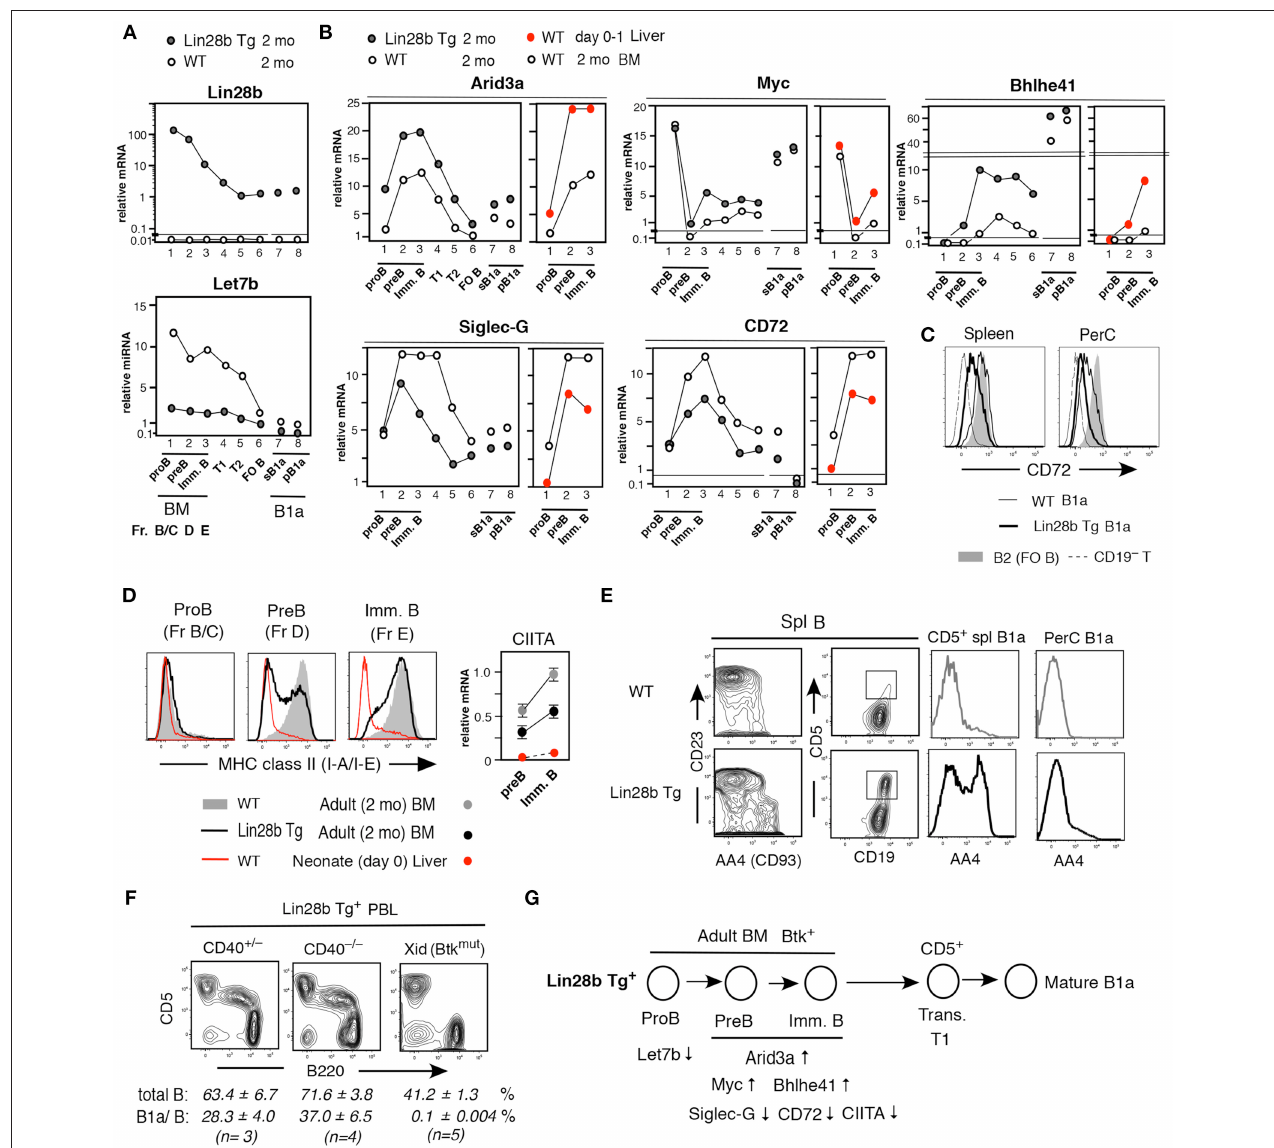
FIGURE 2 | Pre-B and immature B cells in adult Lin28b Tg BM resembles WT fetal/neonatal liver and generate B1a cells. (A,B) qRT-PCR. Adult (2 mo) Lin28b Tg mouse B lineage in BM, B cells in spleen, and B1a cells in spleen (sB1a) and in PerC (pB1a), in comparison to WT mice. (B) Addition of qRT-PCR of WT mouse neonatal (d0-1) liver vs. adult BM B-lineage. The results shown represent the mean of three independent determinations. Samples under the same mouse background showed similar mRNA levels (and mirRNAs). (C) CD72 staining of WT and Lin28b Tg mouse B1a cells in spleen and PerC, and WT B2 cells (FO B cells in spleen). (D) Left; MHC class II staining of pro-B, pre-B, and immature B cells in 2 mo WT and Lin28b Tg BM, and WT d0 liver. Right; CIITA qRT-PCR. n = 3 each; mean ± s.e. (E) Comparison of AA4 + transitional stage in spleen B cells. AA4 level in CD19 + CD5 + B cells in spleen (square region) and PerC, in Lin28b Tg and WT mice. (F) PBL analysis of 2 mo Lin28b Tg mice crossed with CD40 KO mice, and with Xid mice. Total B; CD19 + , B1a/B; B220 lo CD5 + B in total B. (G) Forced expression of Lin 28b Tg in adult BM led to the indicated gene expression changes in pre-B and immature B cells, resembling that of fetal/neonate mice, and increasing the ability to generate B1a